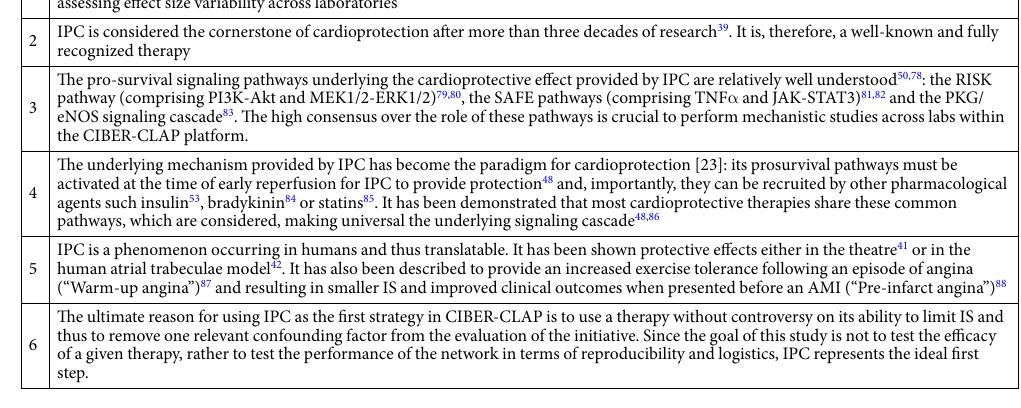
Table 1. Rationale for using local IPC in CIBER-CLAP. AMI, acute myocardial infarction; IPC; ischemic preconditioning; IRI, ischemia/reperfusion injury; RISK, Reperfusion Injury Salvage Kinase; SAFE. Survivor Activator Factor